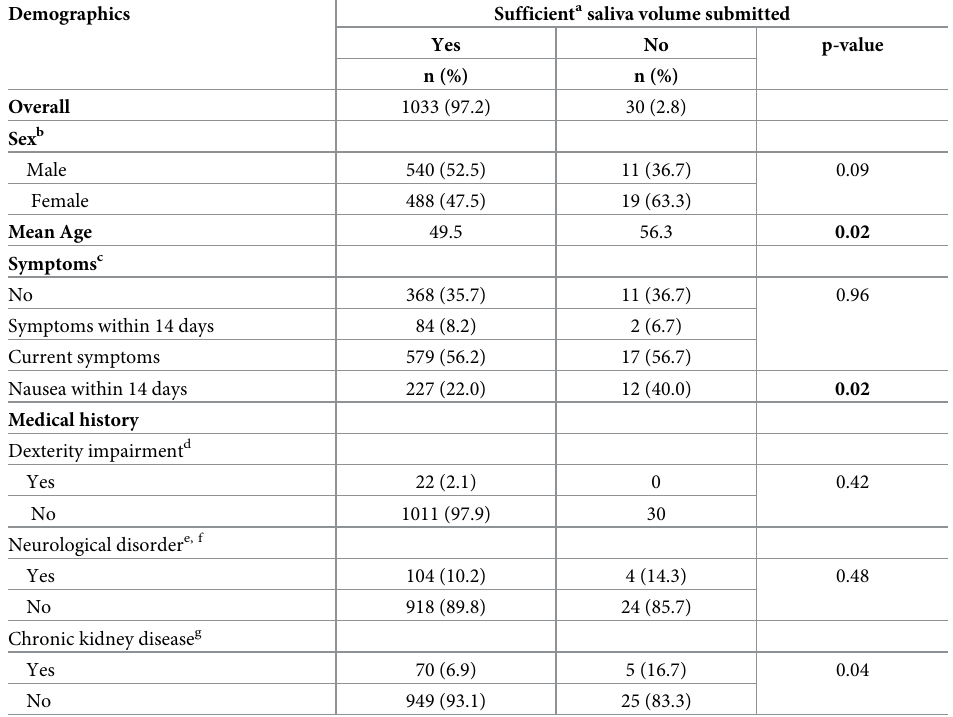
Table 5. Characteristics of participants unable to provide sufficient volume of self-collected saliva for SARS-CoV- 2 detection by RT-PCR at Grady Memorial Hospital—Atlanta, GA, August–October 2020.